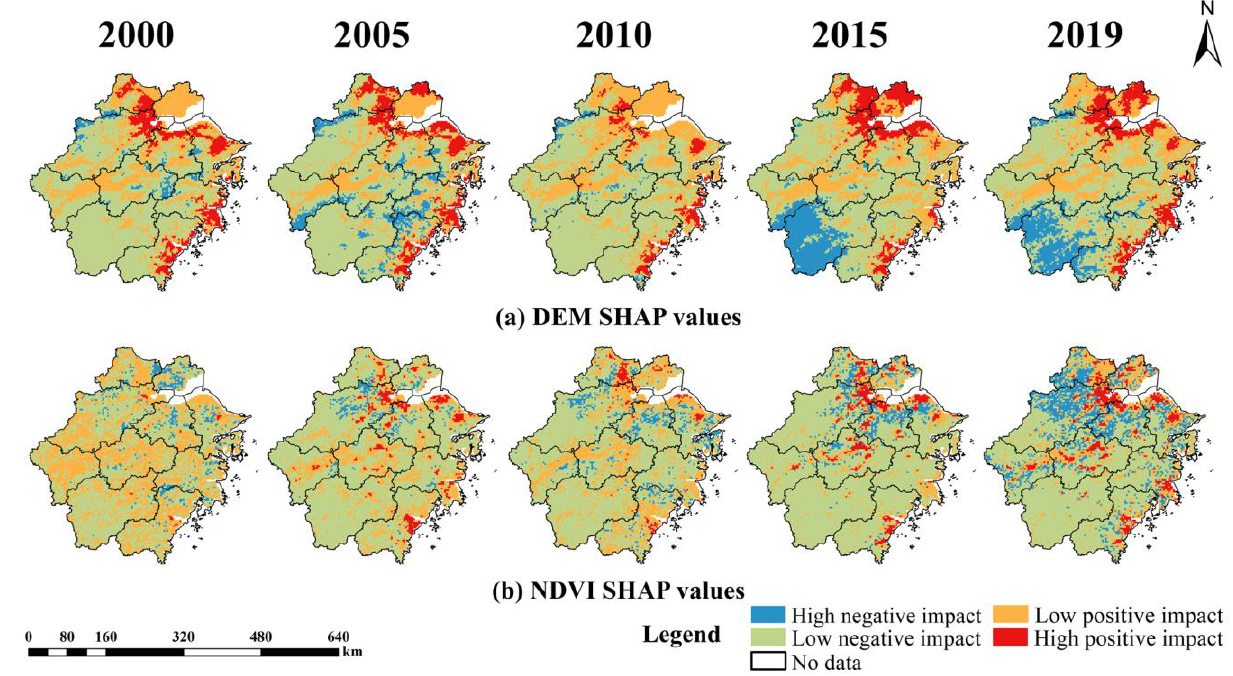
Figure 9. Spatiotemporal variations in SHAP values for topography and land cover factors.